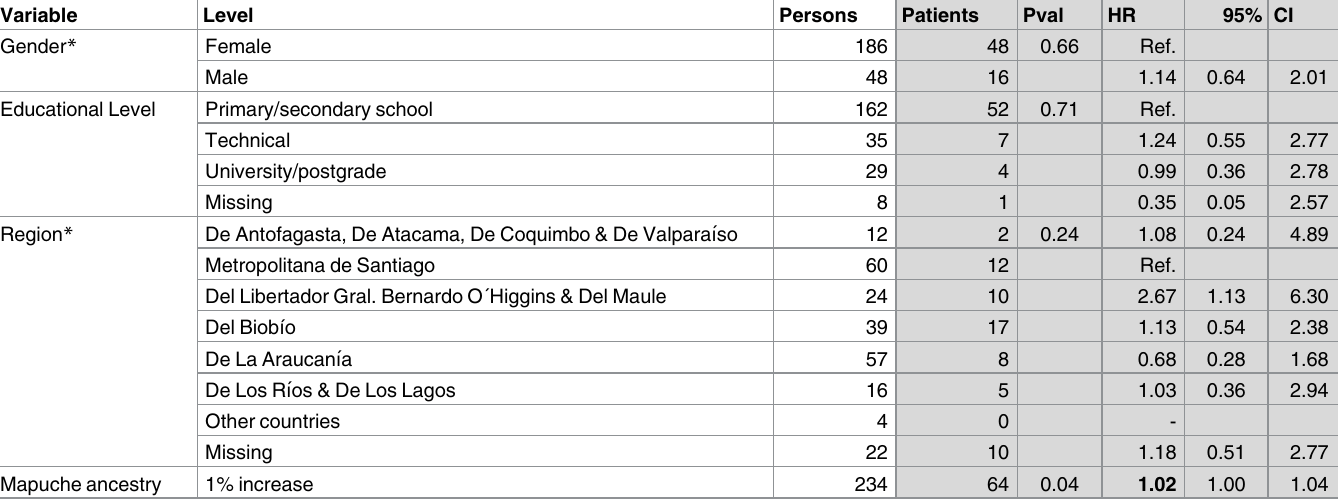
* Gender and region were matching factors and therefore hazard ratios reflect matching weights rather than relative risks for gallbladder cancer, Pval: Global probability value, HR: hazard ratio, CI: confidence interval; Bold represents an associated probability value under 0.05